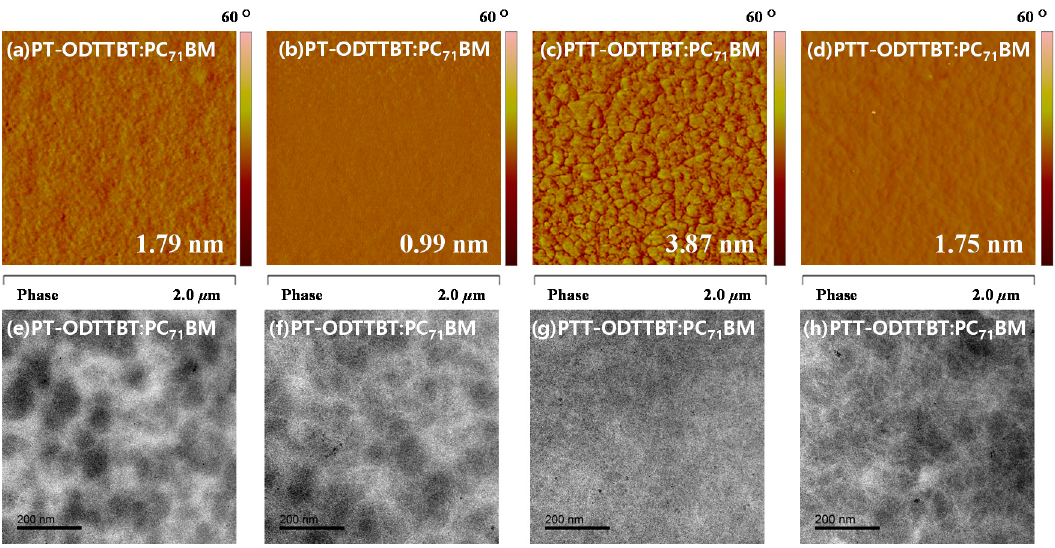
Figure 6. AFM and TEM images (2 μ m × 2 μ m) of ( a , c , e , g ) polymer:PC 71 BM and ( b , d , f , h ) polymer:PC 71 BM w DIO on BHJ films.